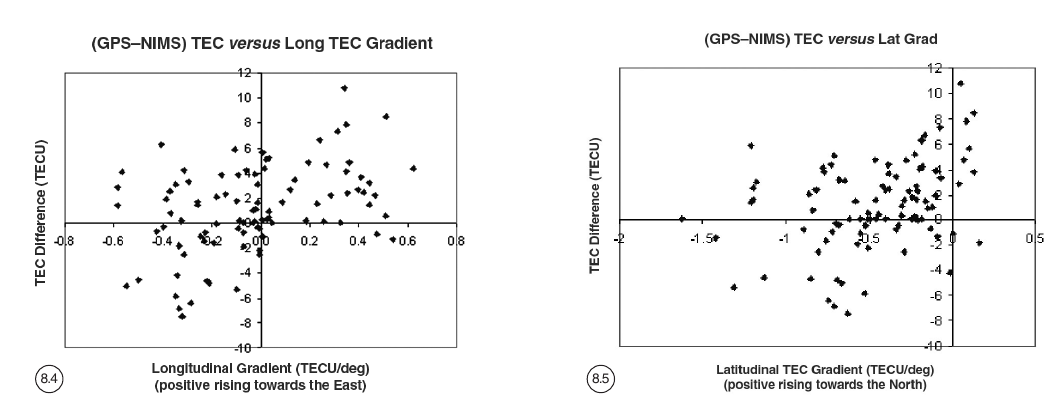
Fig. 8.4. Absolute difference between GPS-TEC and NIMS-TEC estimates as a function of the longitudinal TEC gradient. Fig. 8.5. Absolute difference between GPS-TEC and NIMS-TEC estimates as a function of the latitudinal TEC gradient.